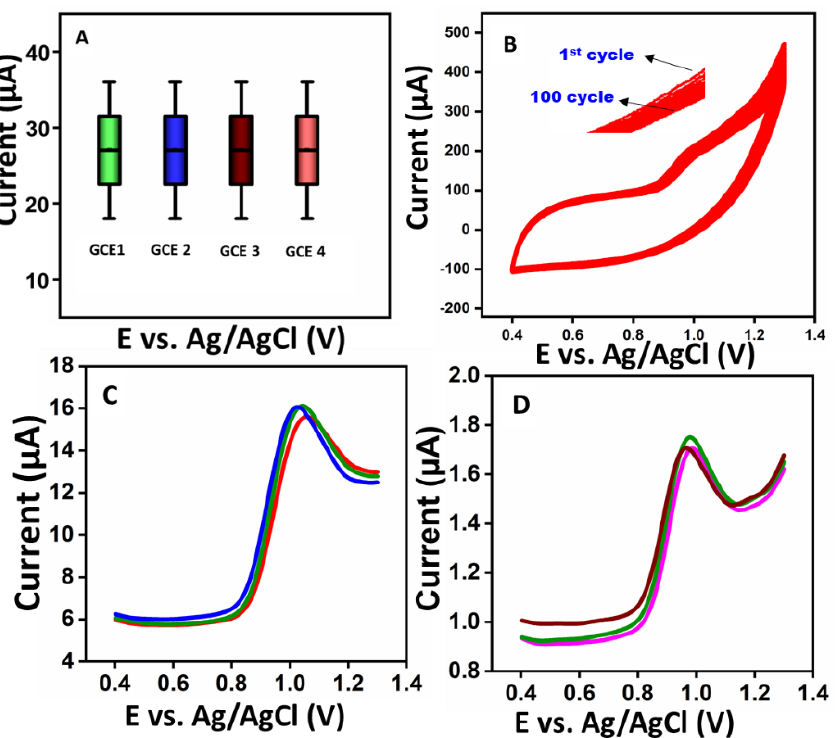
Figure 9. ( A ) Reproducibility studies of various CB/ZnWO4/GCE electrodes; ( B ) stability storage